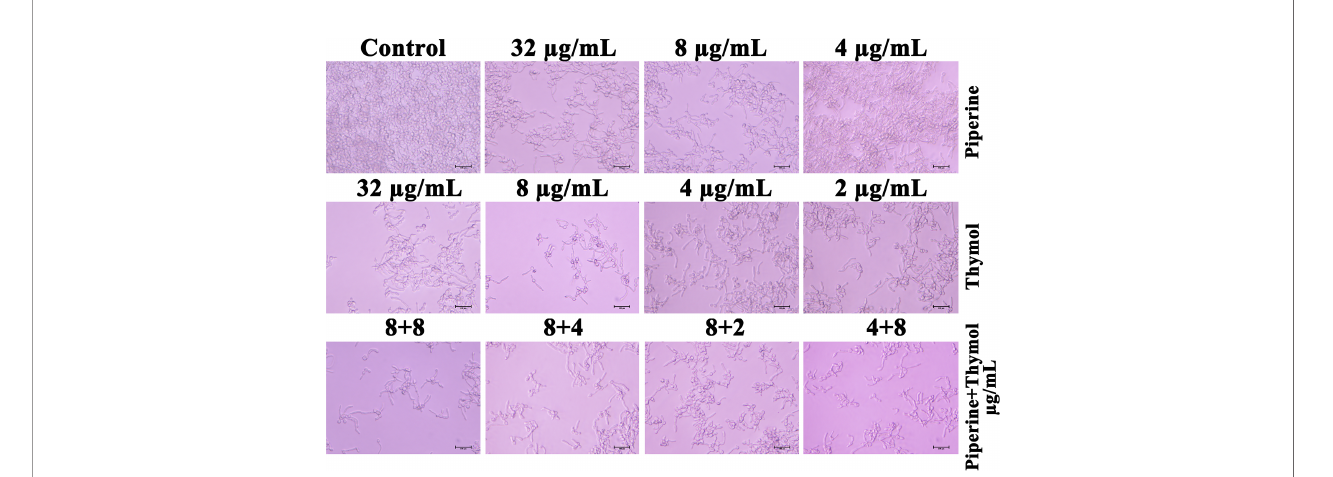
FIGURE 9 | Short-term exposure of C. albicans cells with individual and synergistic combinations of piperine and thymol reduced/delayed the hyphal elongation process.